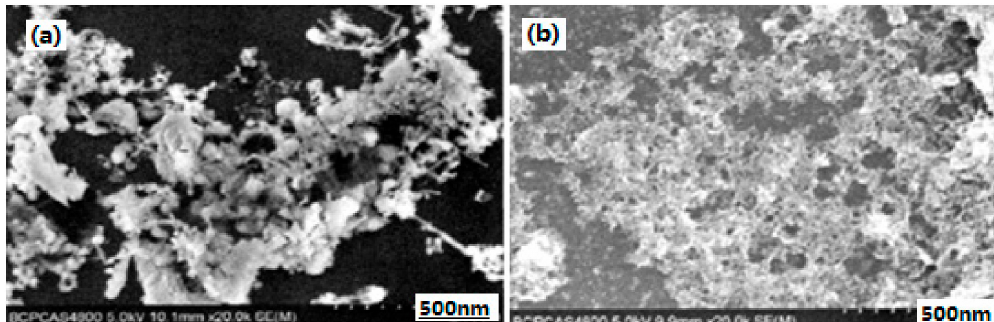
Figure 2. Scanning electron microscopy (SEM) photographs of Fe 2 O 3 aerogel ( a ) and Al / Fe 2 O 3 composite energetic material ( b ). Reproduced from [31], with permission from Huo Zha Yao Xue Bao,